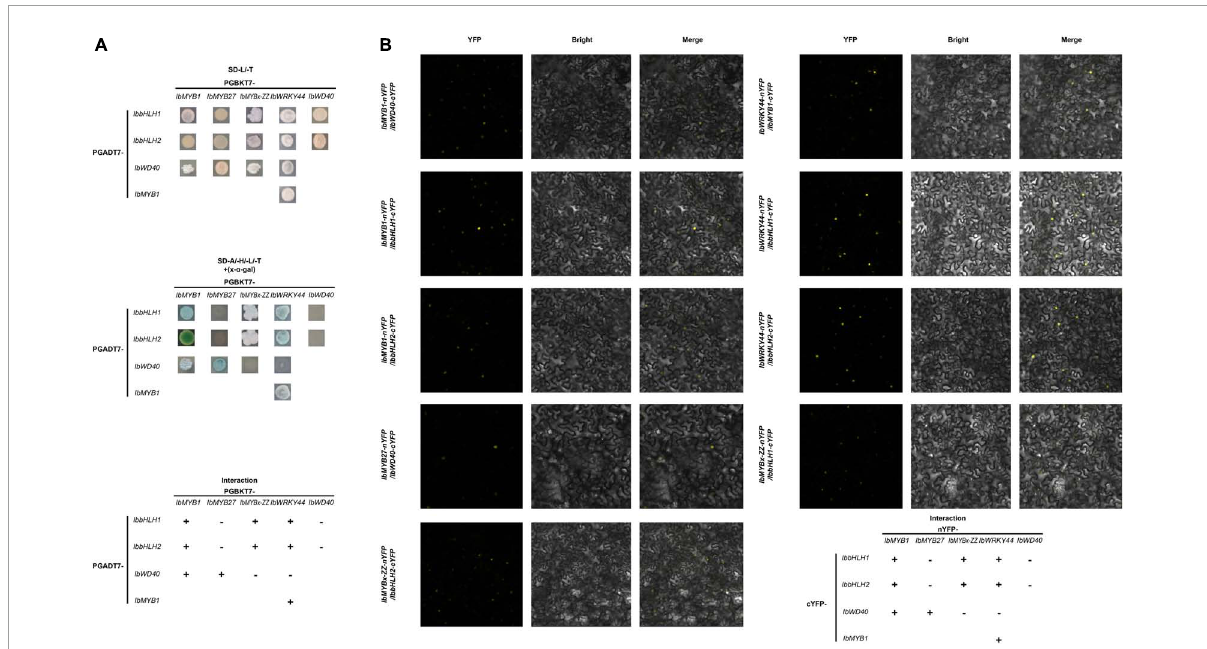
FIGURE8 Interactions of IbMYB1, IbMYB27, IbMYBx-ZZ, and IbWRKY44 with IbWD40, IbbHLH1, or IbbHLH2 in vivo . (A) Interactions of IbMYB1, IbMYB27, IbMYBx-ZZ, and IbWRKY44 with IbWD40, IbbHLH1, or IbbHLH2 in vivo by a yeast two-hybrid (Y2H) assay. (B) Verification of the interaction of IbMYB1, IbMYB27, IbMYBx-ZZ, and IbWRKY44 with IbWD40, IbbHLH1, or IbbHLH2 in vivo by a bimolecular fluorescence complementation (BiFC) assay. Images show overlays of fluorescence and light views. “+” represents positive interaction between these two TFs, whereas “-” represents negative